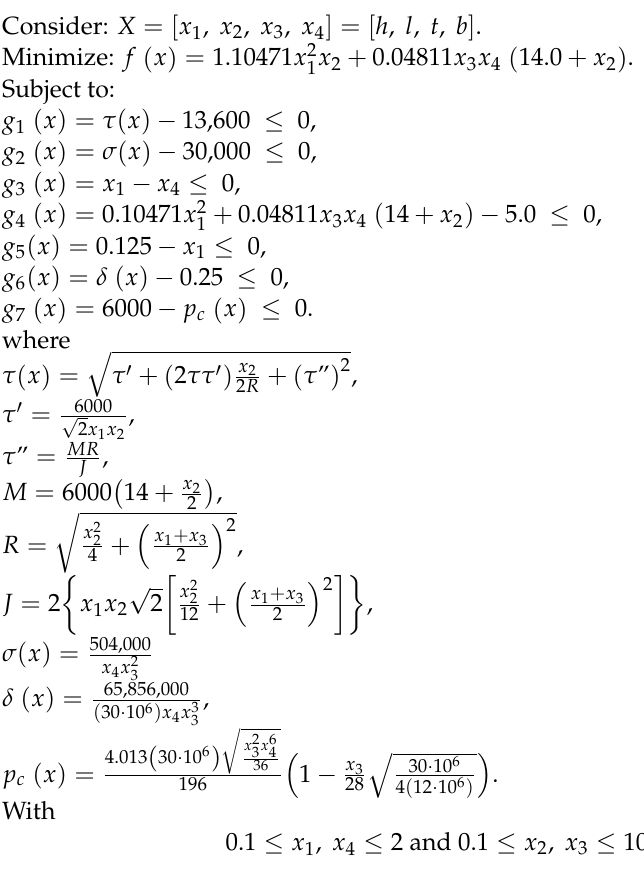
Table 14. Performance of optimization algorithms in the welded beam design problem.